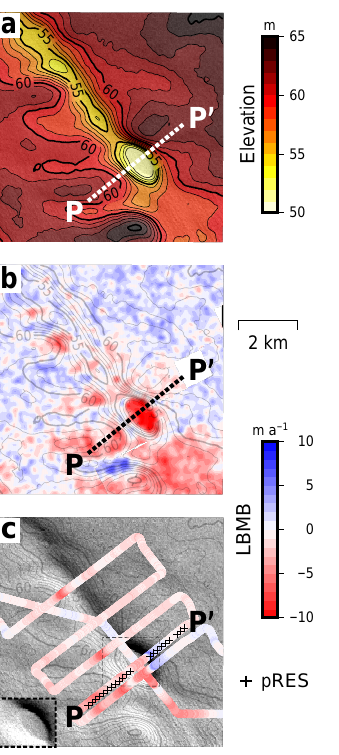
Figure 7. Close-up of the elliptical surface depression, located in Fig. 4. (a) Surface elevation from TanDEM-X DEMs from 2014, (b) LBMB, and (c) Landsat image of 2014 overlaid with the LBMB computed with elevations from the 2014 TanDEM-X DEMs and the 2016 GNSS profiles (using velocities to shift GNSS elevations backward). The crosses locate phase-sensitive radar (pRES) points. The profile PP (cid:48) is shown in Fig. 8. All subfigures are overlain with the surface elevation contour lines of 1m.